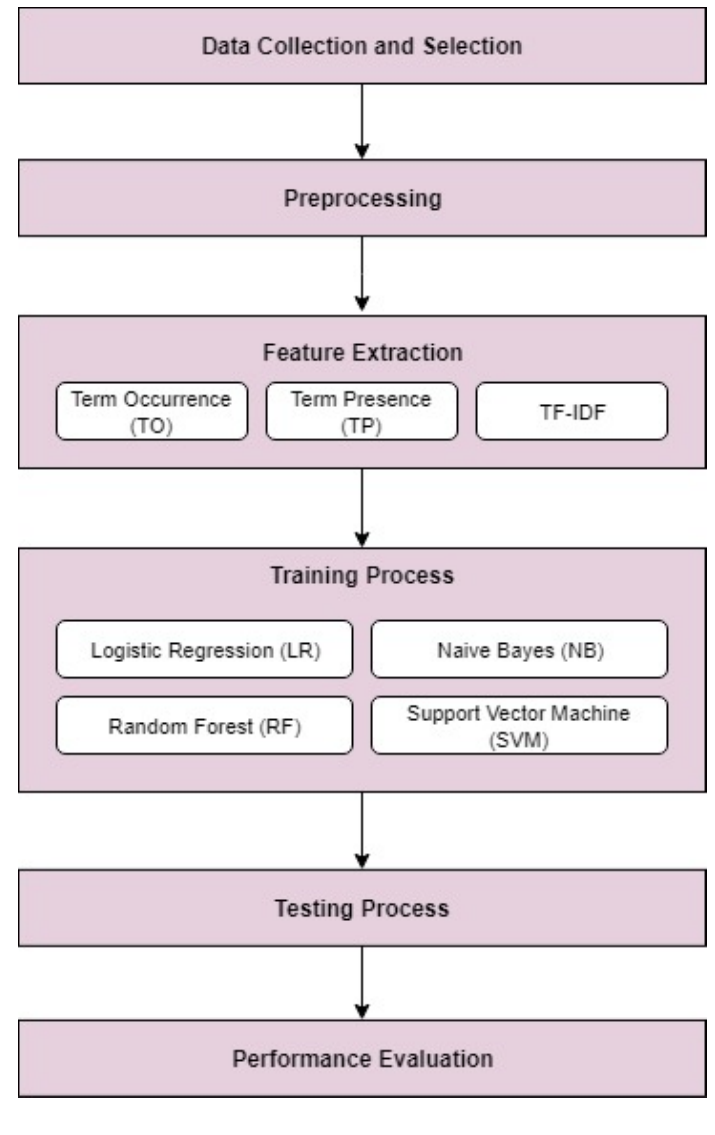
Figure 1. Research methodology.